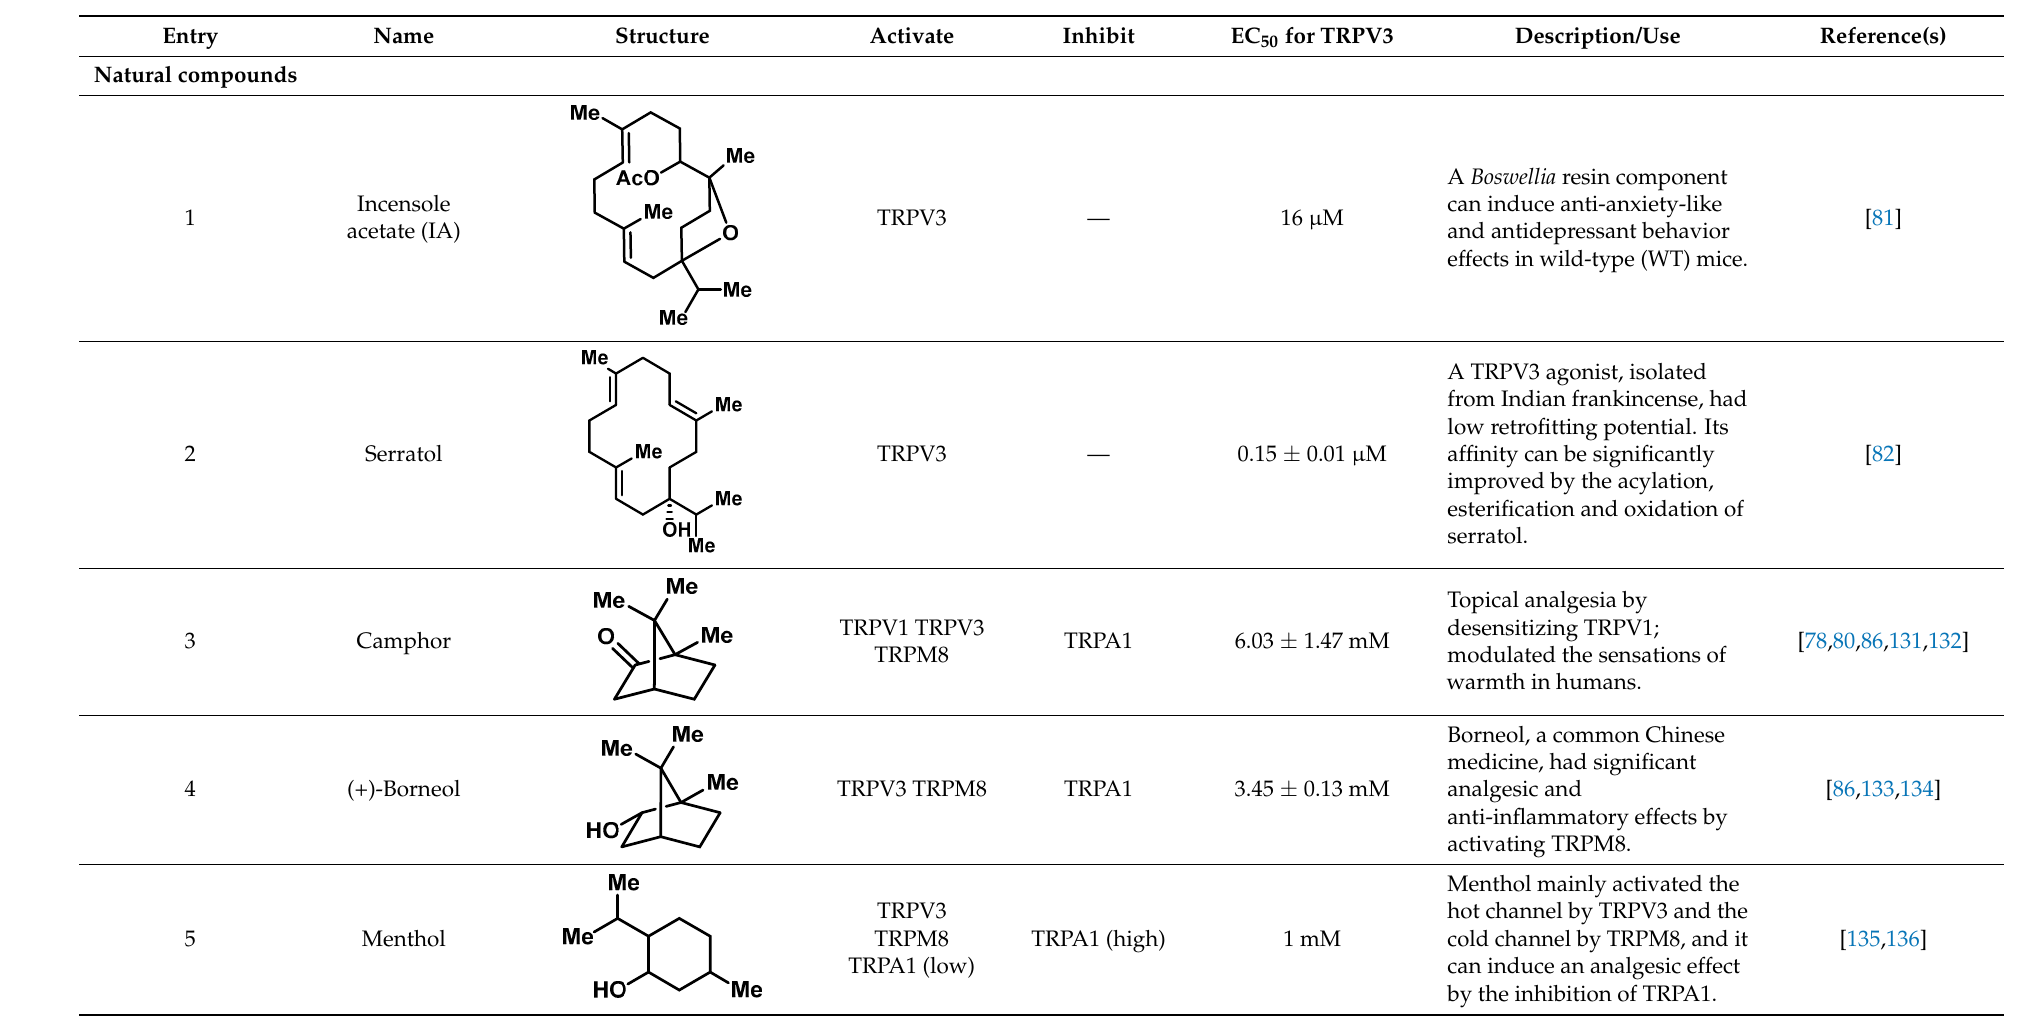
Table 2. TRPV3 agonists.